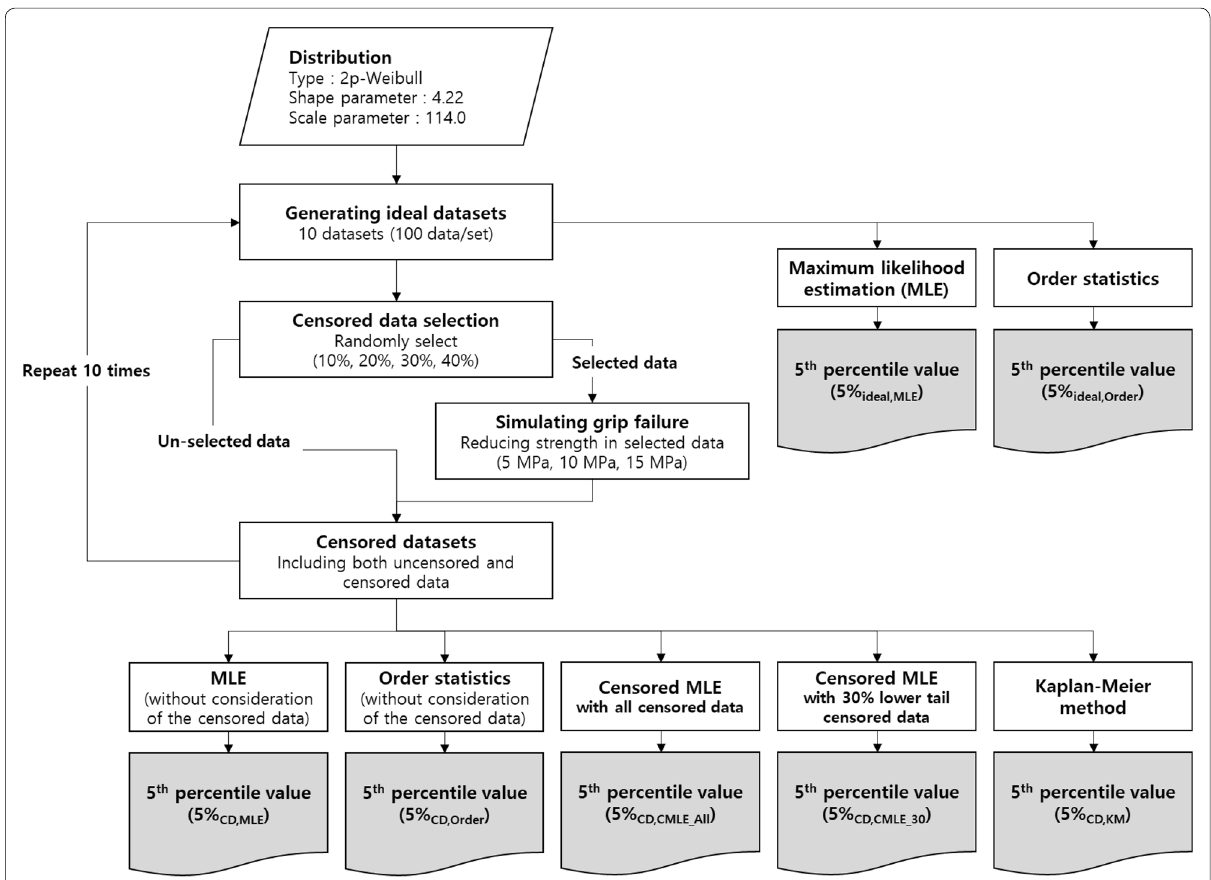
Fig. 1 Generating process and determination of 5th percentile